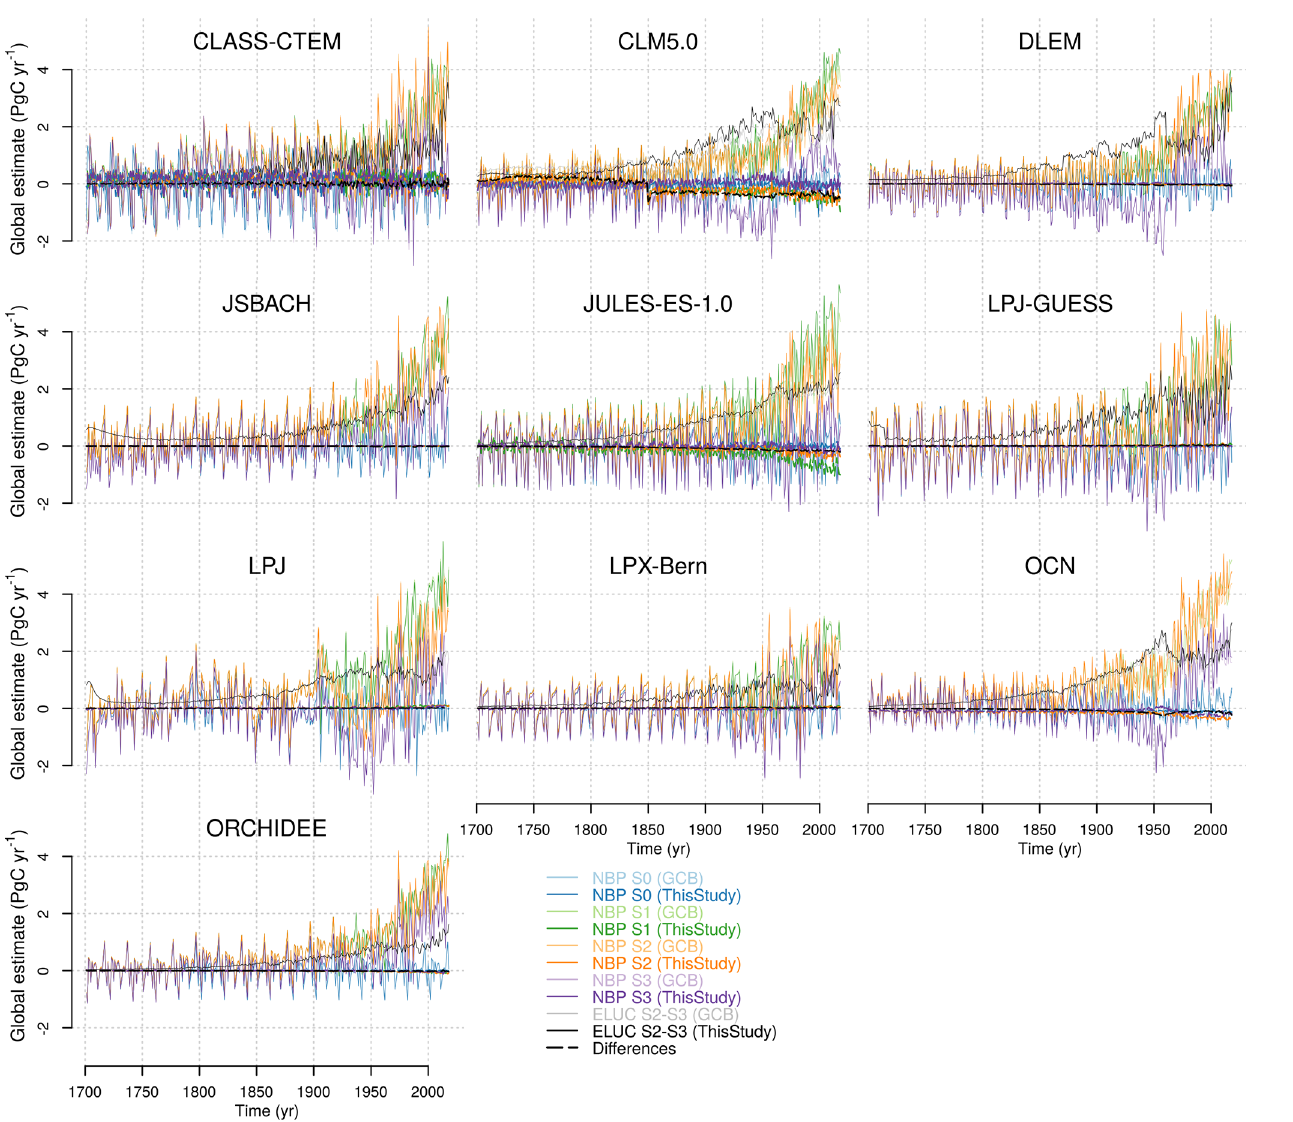
Figure A13. Comparison of global annual NBP of the S0, S1, S2, and S3 simulation runs and derived f LULCC_trans as aggregated in this study and published in the GCB2019 (Friedlingstein et al., 2019). The thick dashed lines (near or at 0) depict the differences (with respective colours). For the global values of this study, CDOs were used to convert NBP data per second to per year (multiplying seconds per day and, depending on the original temporal resolution, days per month or days per year) and to regrid data to the grid cell(multiplying with the area per grid cell). ORCHIDEE-CNP and SDGVM estimates were not shown since no data from the GCB2019 were